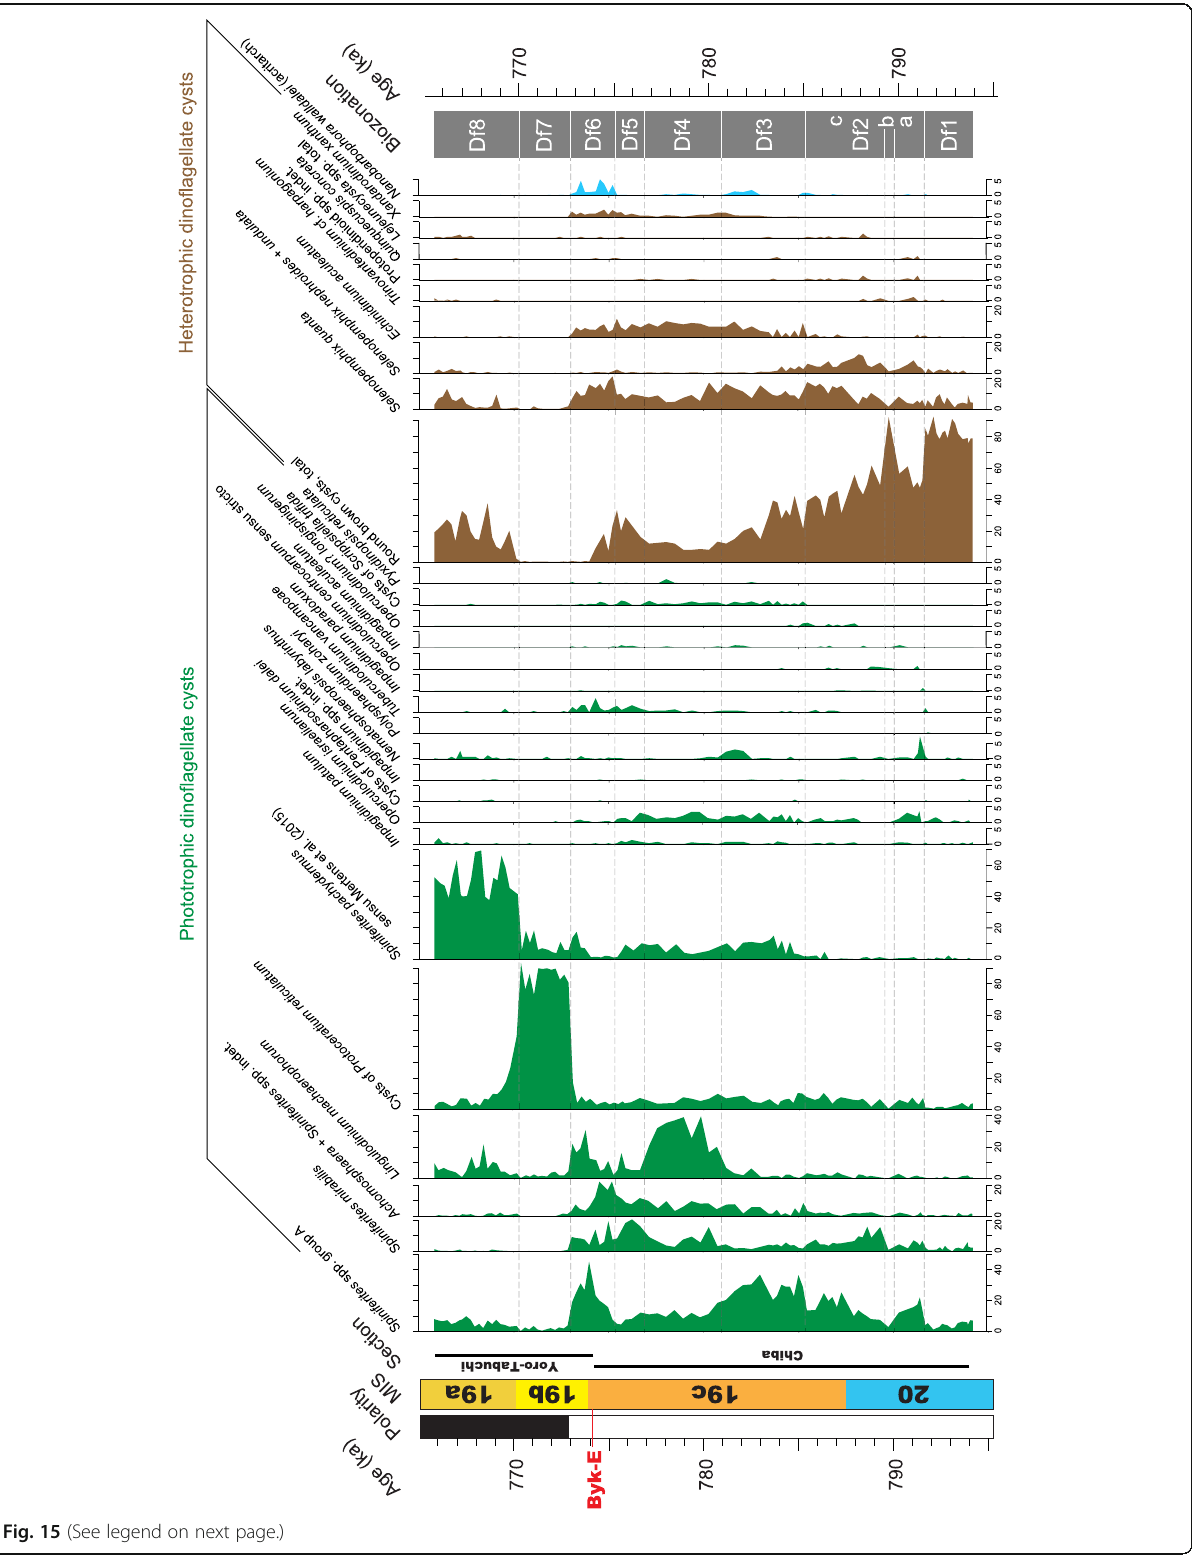
Fig. 15 (See legend on next